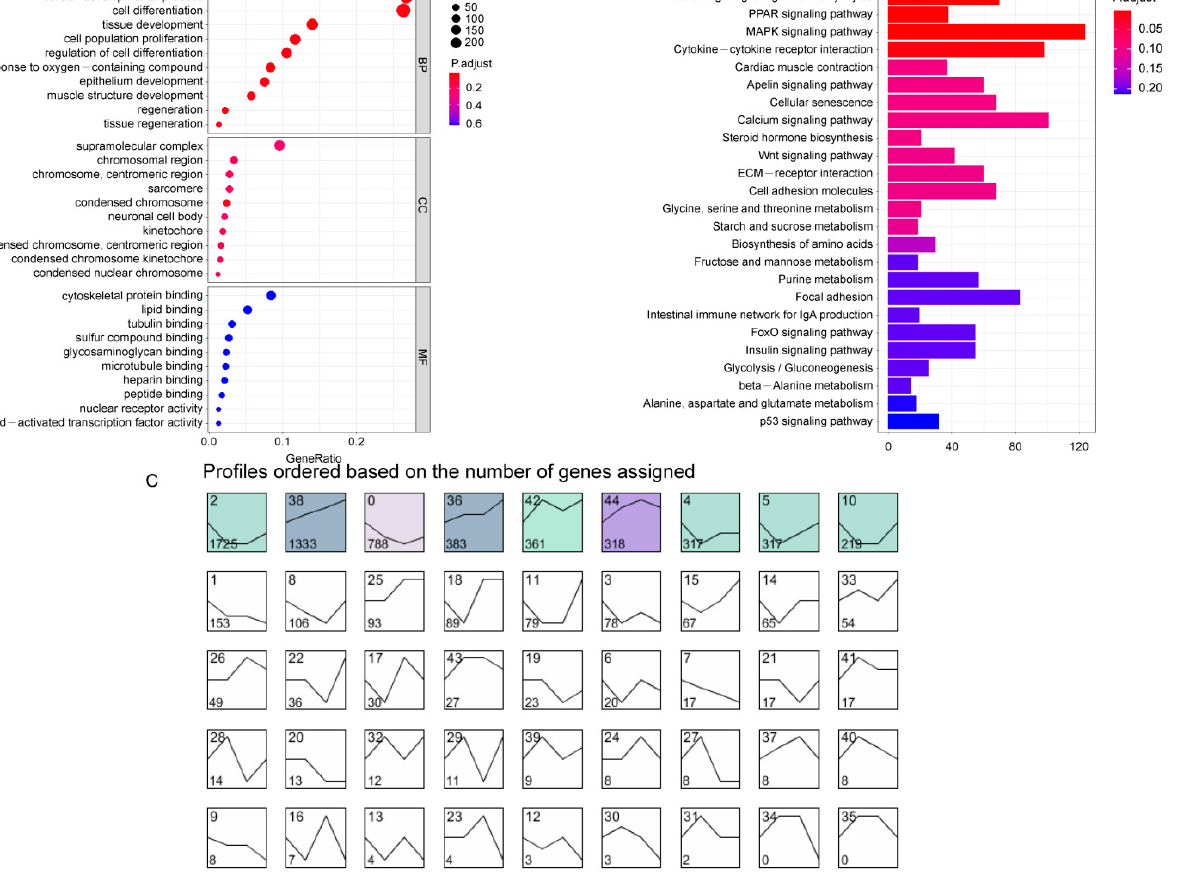
Figure 2. Functional analysis and sample time series analysis of differentially expressed genes (DEGs) of breast muscle at four developmental stages of Beijing-You chicken (BJY). ( A ) The top 10 significant GO enrichment terms. ( B ) The top 25 significant terms by KEGG enrichment analysis. ( C ) Short time-series expression miner (STEM) clustering of DEGs, the color indicates significant difference ( p < 0.05) and gray indicates no significant difference ( p > 0.05).